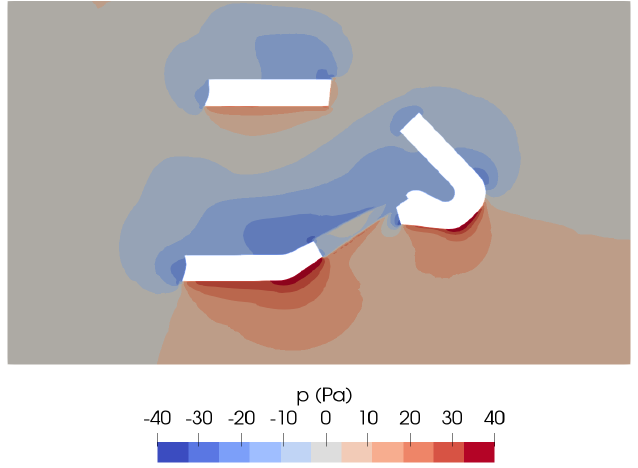
Figure 21. Pressure contour on ENI Head Office, at height 0.5 m model scale.